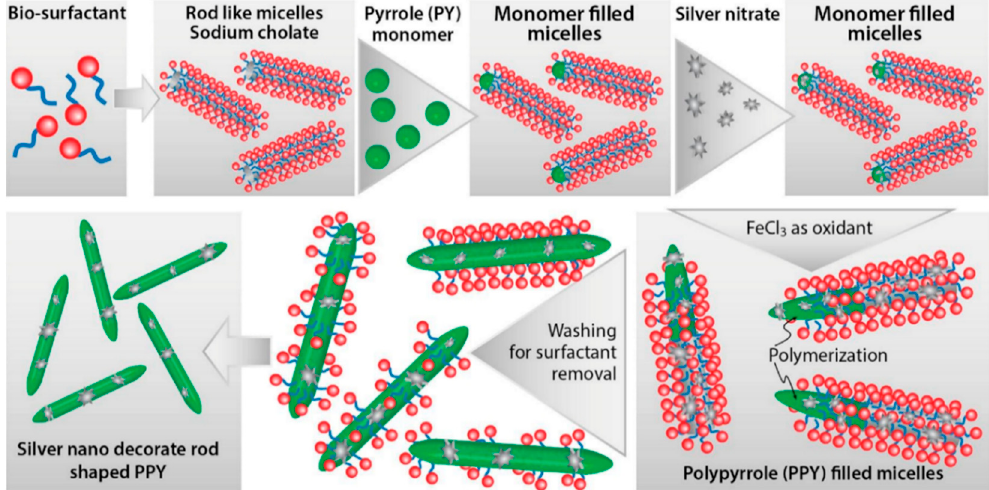
Figure 2. Schematic representation of the fabrication process of composite polypyrrole (PPy)-Ag. Reproduced with permission from [93]. Copyright 2020 Elsevier B.V.